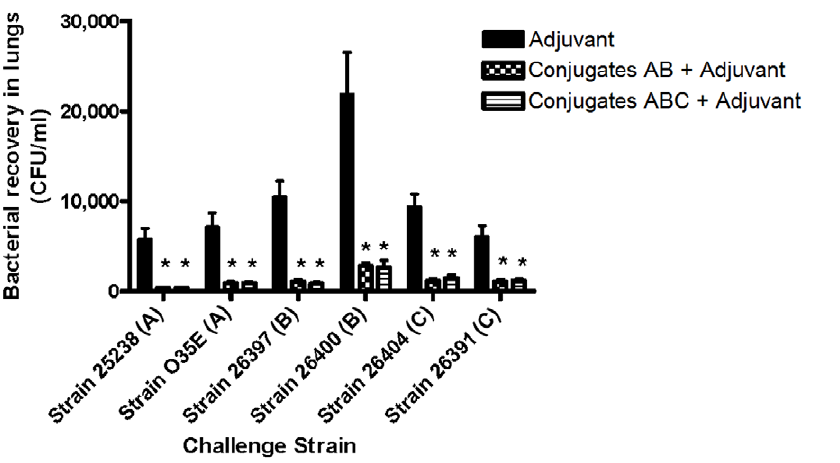
Figure 2. Pulmonary bacterial recovery after challenges with three serotypes of M.catarrhalis . Mice (8 – 10 per group) were vaccinated intranasally (1 dose per week, 4 doses in total) with either the adjuvant cholera toxin alone (1 m g/dose/mouse) or the combined conjugates AB or ABC (2.5 m g of each carbohydrate per dose per mouse) plus adjuvant. One week after the last booster, mice were challenged with aerosolized M. catarrhalis including 25238 (type A), O35E (type A), 26397 (type B), 26400 (type B), 26404 (type C), or 26391 (type C) (5 6 10 8 to 1 6 10 9 CFU/ml). Mouse lungs were harvested at 6 h after the challenge for bacterial counts. The viable bacteria are expressed as the mean of CFUs 6 standard error of the mean (SEM). * P , 0.05 indicates the significant difference vs adjuvant control by ANOVA.